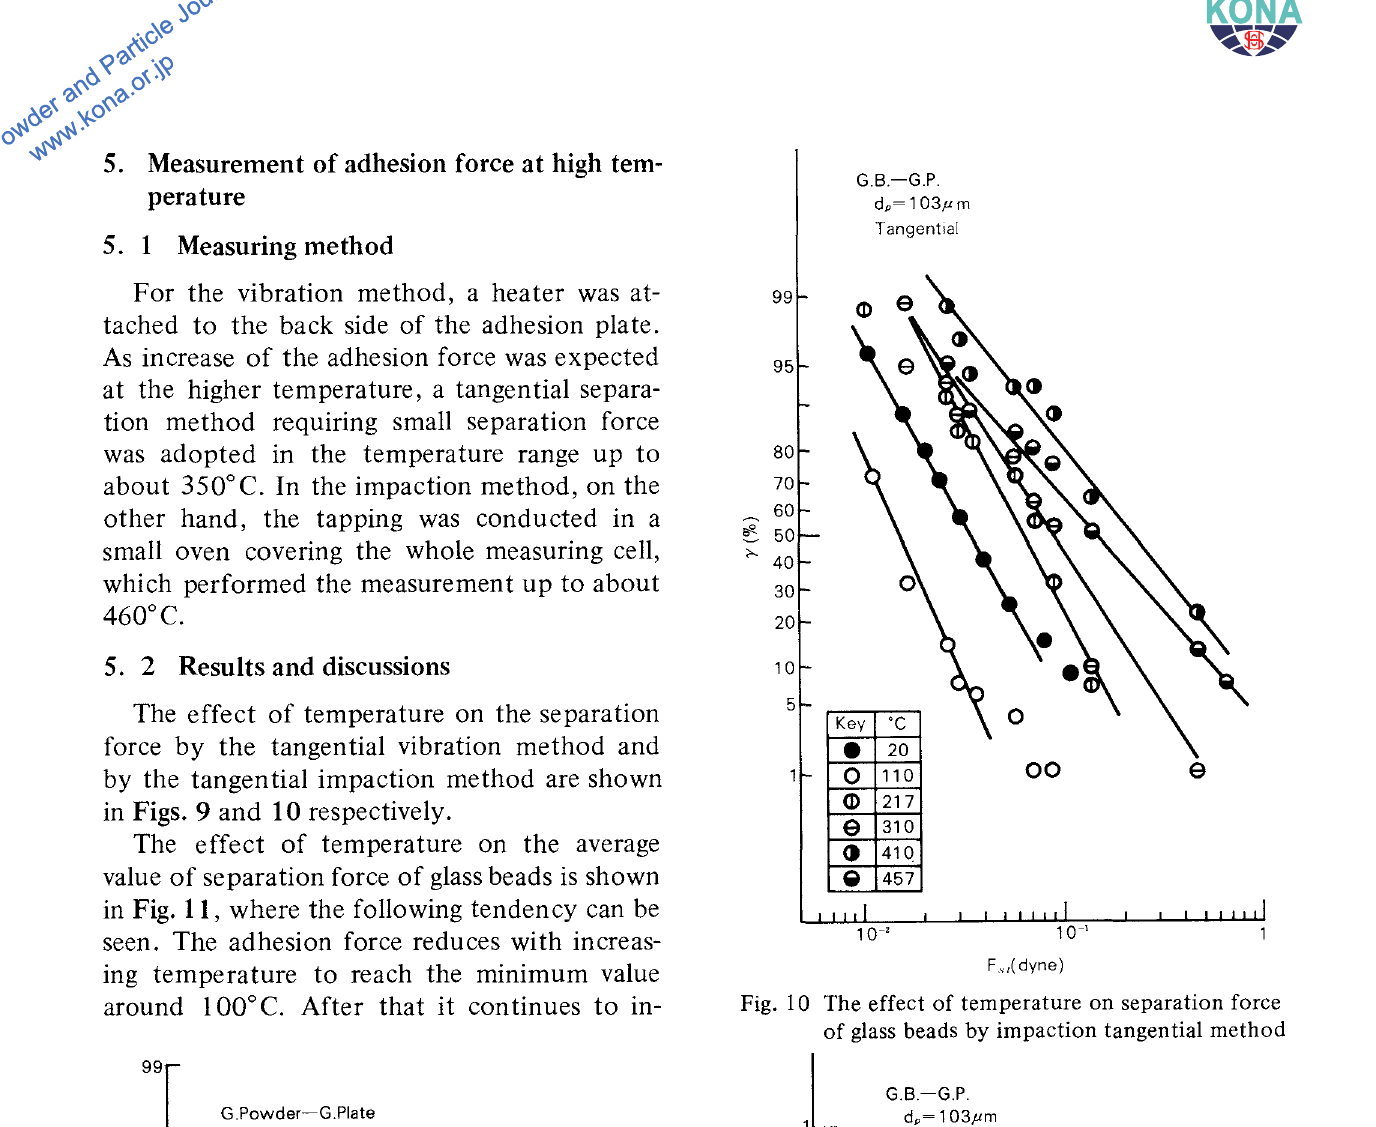
Fig. 1 0 The effect of temperature on separation force of glass beads by impaction tangential method G.B.-G.P. dP~ 1 03p.m